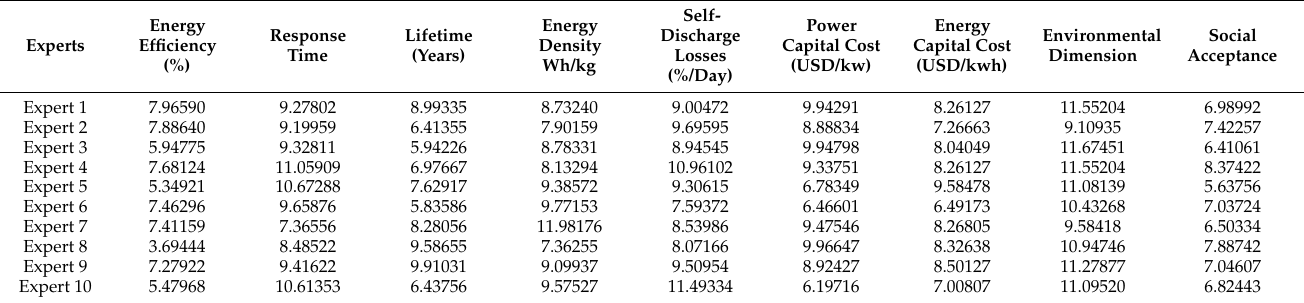
Table A19. The average value matrices for each